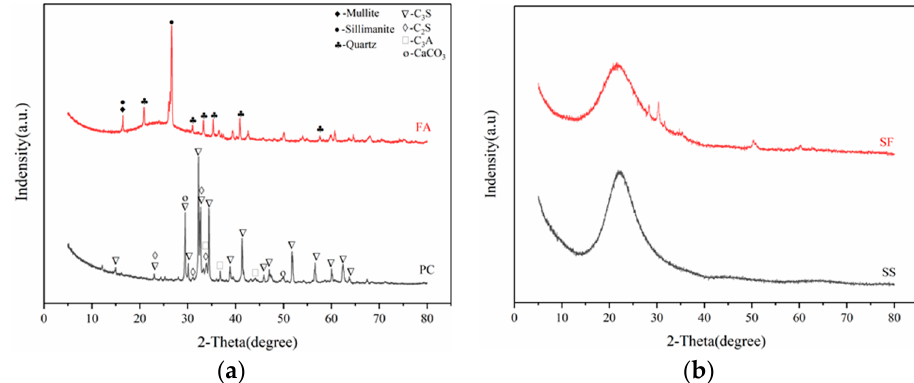
Figure 1. XRD patterns of raw materials. ( a ) cement and FA; ( b ) SF and SS.